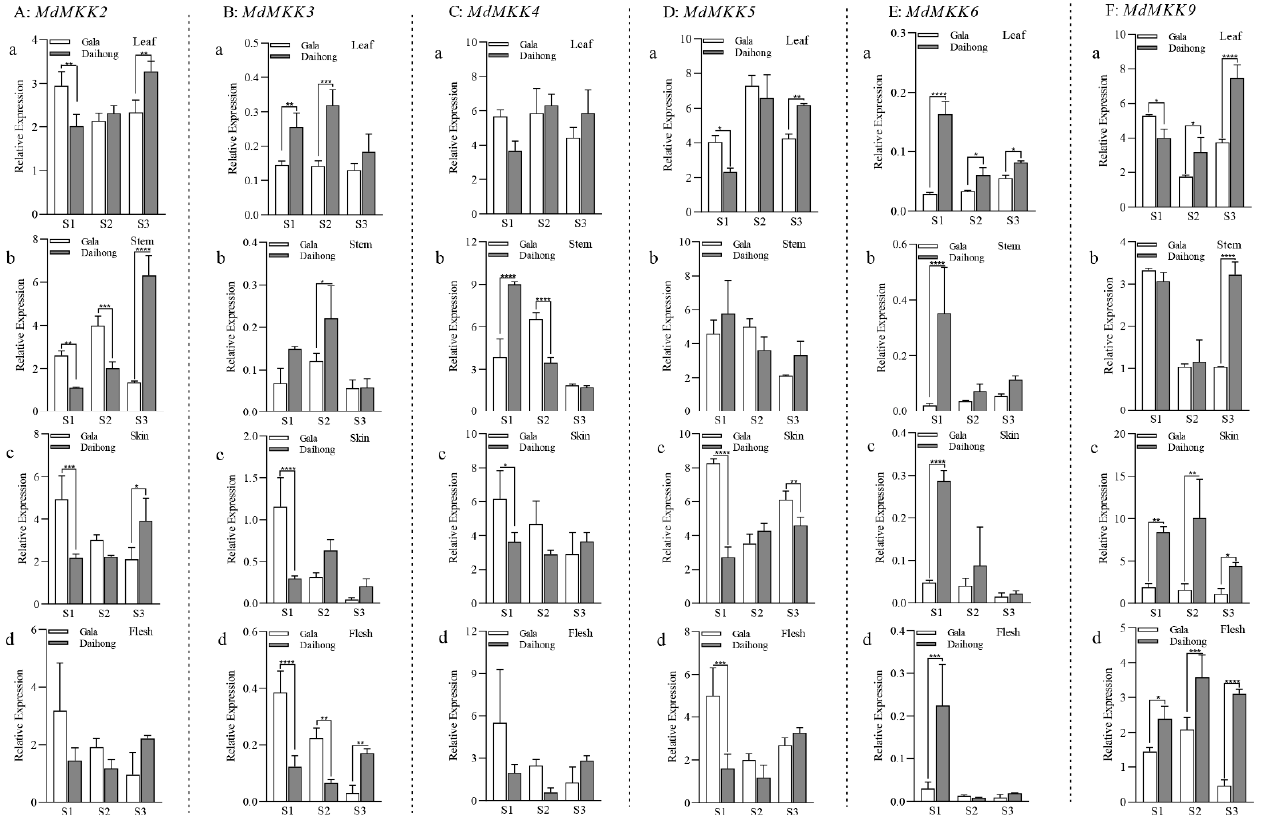
Figure 2. Relative expression levels of genes in the MAPK gene family at different developmental stages in ‘Gala’ and ‘Daihong’. ( A ) MdMKK2 ( a , Leaf, b , Stem, c , Skin, d , Flesh, the same below). ( B ) MdMKK3 . ( C ) MdMKK4 . ( D ) MdMKK5 . ( E ): MdMKK6 . ( F ): MdMKK9 . The relative gene expression was calculated according to the 2 −Δ CT method . The bars represent means ± SD ( n = 3). Asterisks